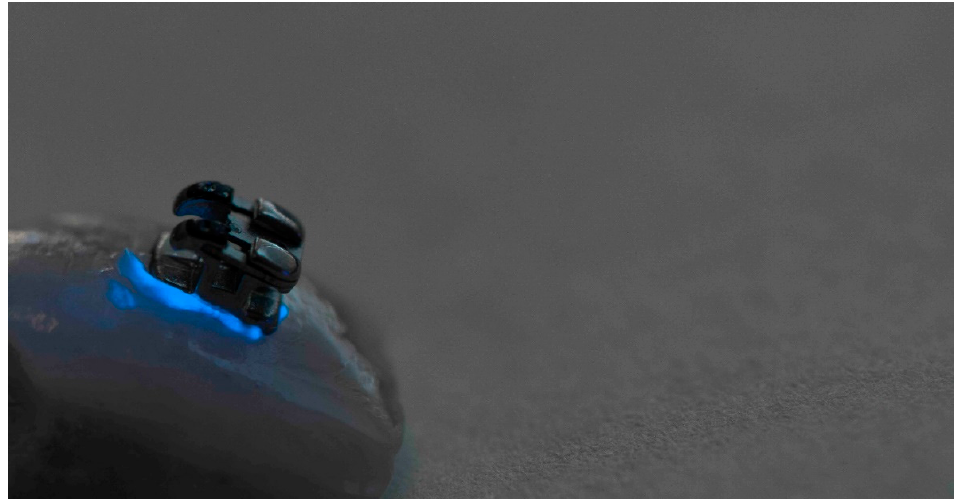
Figure 1. Bracket and composite observed under UV light (360–370 nm 20 mW/cm 2 ).